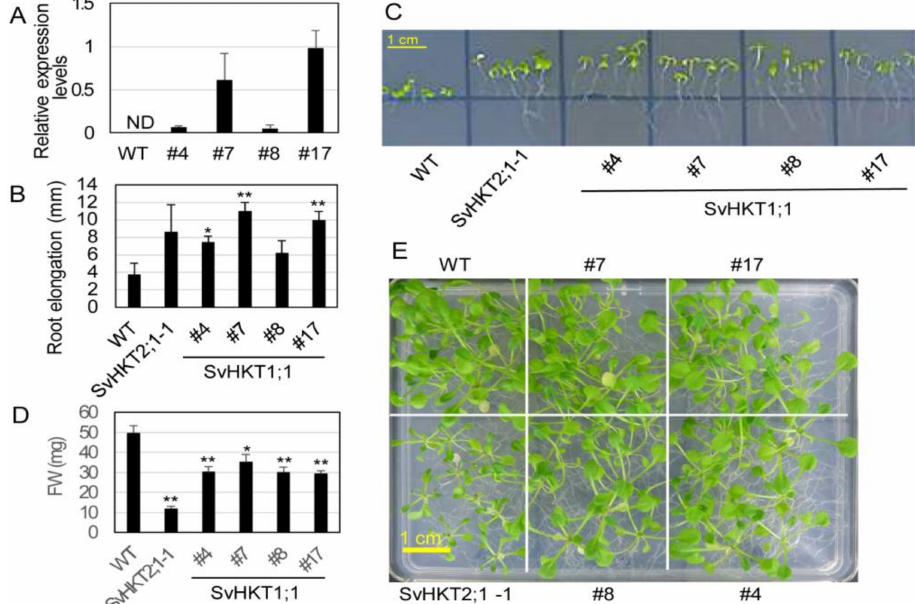
Figure 6. Expression level of the transgene, root growth, and salt tolerance of transgenic Arabidopsis plants expressing SvHKT1;1 . ( A ) Expression levels of transgenes in the SvHKT1;1 transgenic lines. Actin was used as an internal standard. ND; not detected. Data are presented as means ± SE ( n = 3 biological replicates). ( B ) Root elongation of transgenic and WT seedlings grown on 0.1 mM K + medium. Data are presented as means ± SE ( n = 3 biological replicates). ( C ) The appearance of transgenic lines and WT seedlings on 0.1 mM K + medium examined in panel B. ( D ) Fresh weight (FW) of WT and the transgenic lines. One-week-old seedlings germinated on 1 / 2 MS agar medium were transplanted onto 1 / 2 MS agar medium supplemented with 50 mM NaCl, and their FW was determined after another two weeks of incubation. Data are presented as means ± SE ( n = 10 biological replicates). ( E ) The appearance of plants examined in panel D. Single and double asterisks denote significant di ff erences compared with the values of WT plants of the same conditions at p < 0.05 and p < 0.01, respectively, determined using the Student’s t -test.